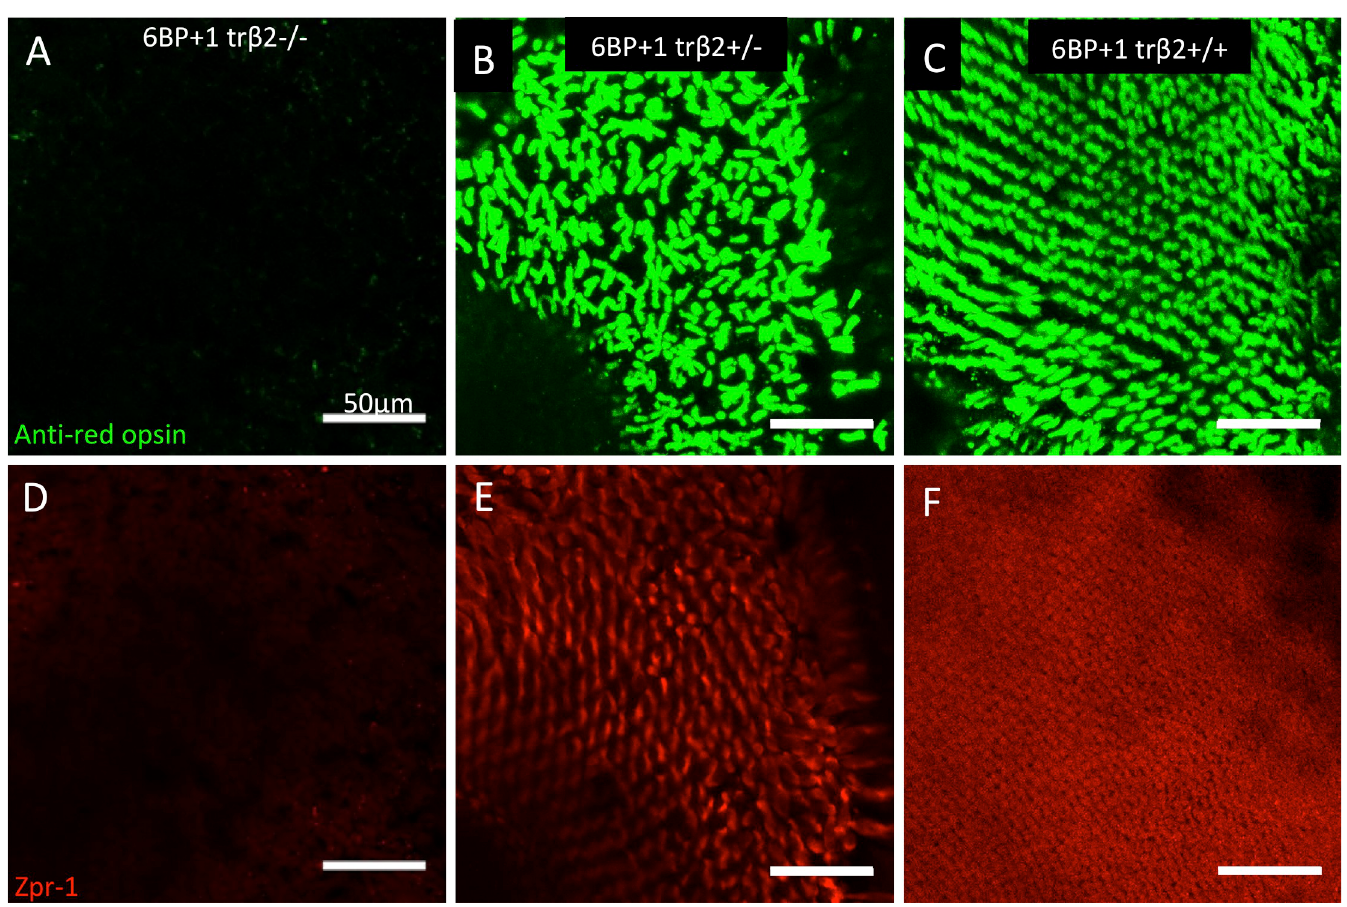
Fig 4. Anti-red opsin and zpr-1 antibody staining of 6BP+1 adult. (A, D) Mutant adult retinas (N = 4) did not have red opsin or arr3a (red-green double-cone) antibody fluorescence. (B, E) Heterozygote adult retinas (N = 4) showed bright antibody staining for red opsin and arrestin3a as seen in the wild type (N = 4) (C, F). Scale is the same for each image. Opsin and arr3a images are from the same microscope field, but different planes of focus. Staining was repeated twice for each genotype.